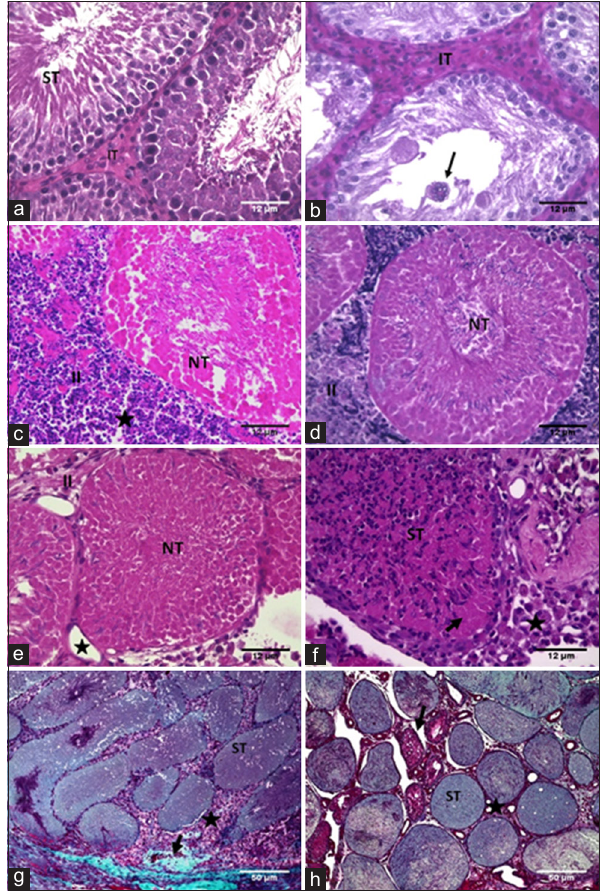
Figure-1: Photomicrographs of testis (hematoxylin- eosin) of adult rats submitted to intratesticular injection of a zinc-based solution and treated with different anti- inflammatory drugs for 7 days and evaluated at 15 and 30 days. (a) Seminiferous tubule (ST) at Stage VII of the seminiferous epithelium cycle and intertubular tissue (IT) in the control group. (b) Animal treated only with dimethyl sulfoxide (DMSO). Note the increased IT and syncytial giant cells (arrow). (c) Necrotic seminiferous tubule (NT) and increased IT (II) with inflammatory infiltrate and cellular debris (star) in an animal treated only with dipyrone. (d) Necrotic seminiferous tubule (NT) and increased IT with inflammatory cells and cellular debris (II) in the celecoxib-treated group. (e) Animal treated with meloxicam, note necrotic seminiferous tubule (NT), increased IT (II) and blood vessels (star). (f) Animal treated with dexamethasone. Note ST within polymorphonuclear leukocyte infiltrates (ST), germ cell necrosis (arrow), and IT with macrophages (star). (g) Animal treated with dipyrone stained using Gomori Trichrome. ST within necrotic germ cells (ST), IT filled by macrophages (star) and fibrosis (arrow). (h) Animal treated only with DMSO stained using Gomori Trichrome. ST within necrotic germ cells (ST) and IT without inflammatory cells (star). Note atrophic ST (arrow).